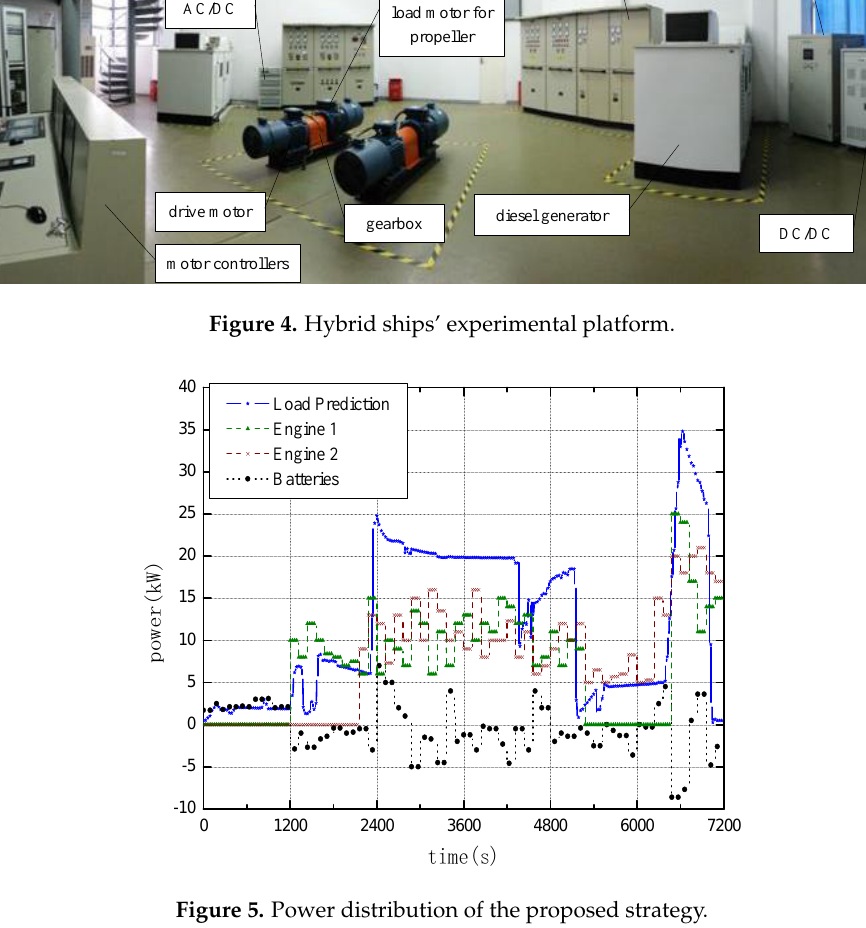
Figure 5. Power distribution of the proposed